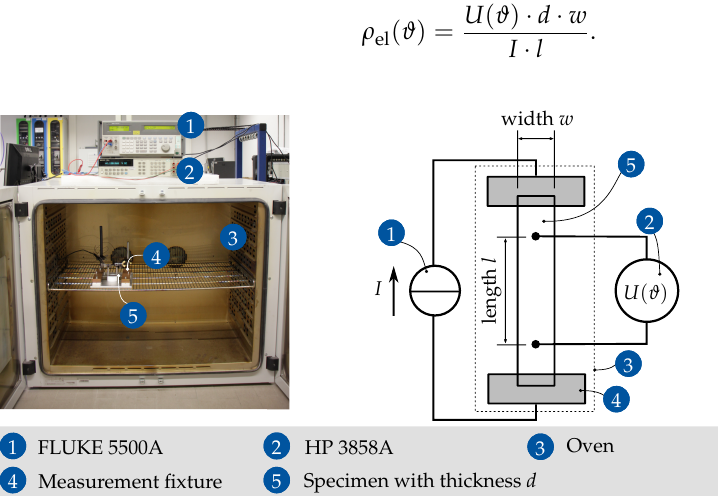
Figure 1. Measurement setup for the electric resistivity. A DC-current I between 0.2 A and 2 A is introduced into the sample using a FLUKE 5500A Multi-Product Calibrator [15]. The maximum measurement error of this current is given by ∆ I = 0.64 mA in the manufacturer data sheet [15]. The voltage is measured with a separate device to improve the accuracy of the measurement. A HP 3458A Multimeter is used for this purpose. The maximum measured voltage during the procedure is around 20 mV. With an maximum measurement error of 16.4 ppm of the reading and 22 ppm of the measurement range, a maximum measurement error for the voltage of ∆ U = 2.5 µV is specified in the data sheet of the device [16]. Two measurement tips are placed on the probe for the voltage measurement. The distance between the measurement tips is equal to the measuring length l . The measuring length l as well as the width of the specimen w are measured using a digital caliper from Mitutoyo. The maximum measurement error of the measurement device is given with 0.02 mm. In order to include measurement errors that result from geometrical deviations, a total error estimation of ∆ l = ∆ w = 0.05 mm is included in the accuracy calculation. The measurement of the two values is repeated at least three times and the average value is calculated. The thickness of the sheet d is measured after removing the insulation, using an outside micrometer from Mitutoyo. The measure- ment is repeated six times and the average value is used. The coefficient of variation cv of the iterative geometrical measurement procedure is given in Table 2. cv is well below 1% with one outlier of material M8 for the thickness measurement. The measurements show good